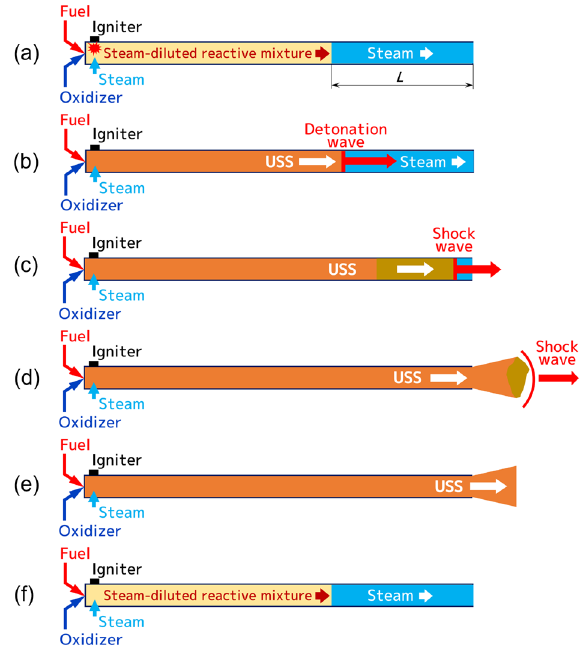
Figure 1. Phases of the operation cycle of the USS generator: ( a ) ignition of the reactive mixture; ( b ) flame acceleration and DDT followed by detonation propagation; ( c ) detonation-to-shock transition followed by shock compression and heating of steam; ( d ) USS expansion to ambience; ( e ) filling with steam; ( f ) filling with the reactive mixture. The operation cycle continues by repeating phase ( a